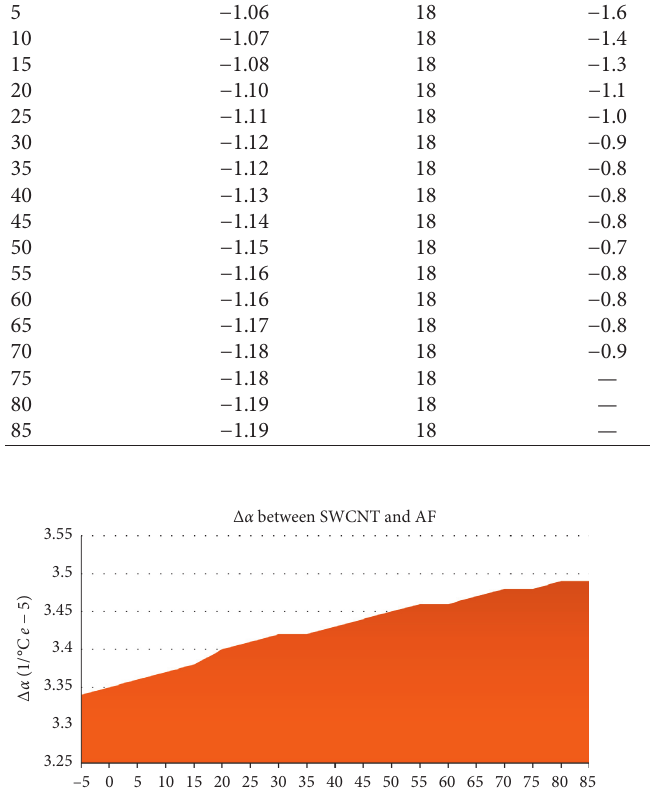
Figure 4: Mismatch between the CTEs of MWCNTand AF ( Δ α ) in temperature range of − 5 to 70 ° C within the MWCNTAF.